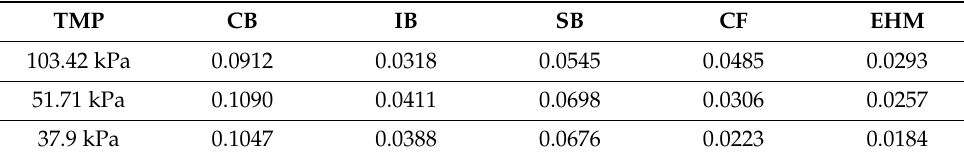
Table 7. RMSE results obtained in Example 2 for CM05 at different TMPs. TMP CB